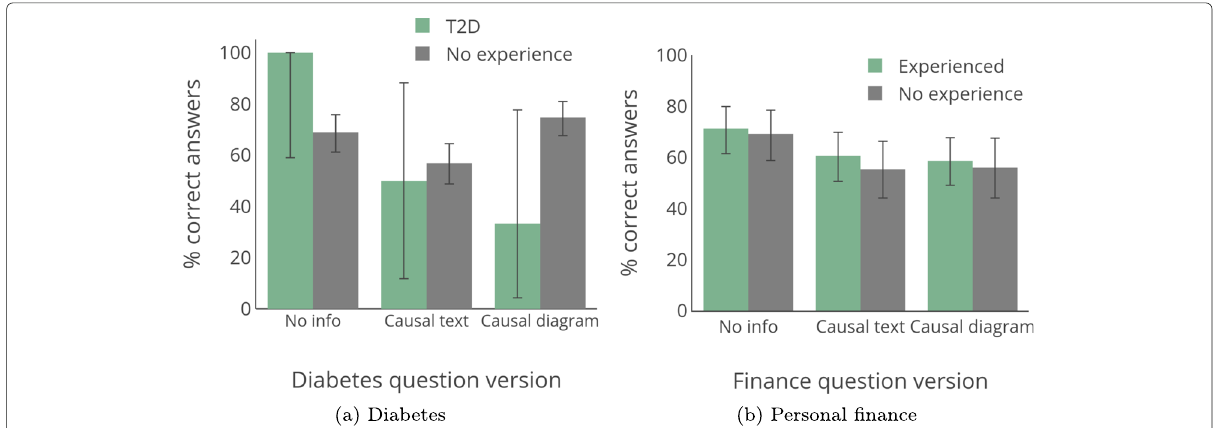
Fig. 10 Results for real-world decision-making questions in Experiment 4 broken down by level of domain experience. Error bars show 95% confidence interval. a Diabetes. b Personal